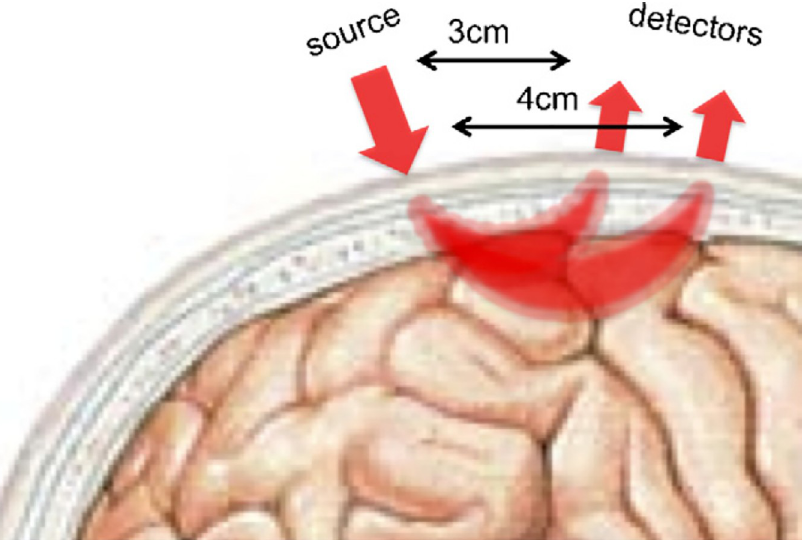
Fig 1. Functional near-infraredspectroscopy (fNIRS) records cortical hemodynamic responses in populations that cannot comfortably be inside the MR scanner such as young infants. Pairs of detectors and emitters form an fNIRS channel(from Gervain et al., 2011 with permission) which covers a localizable regionof the cortex.